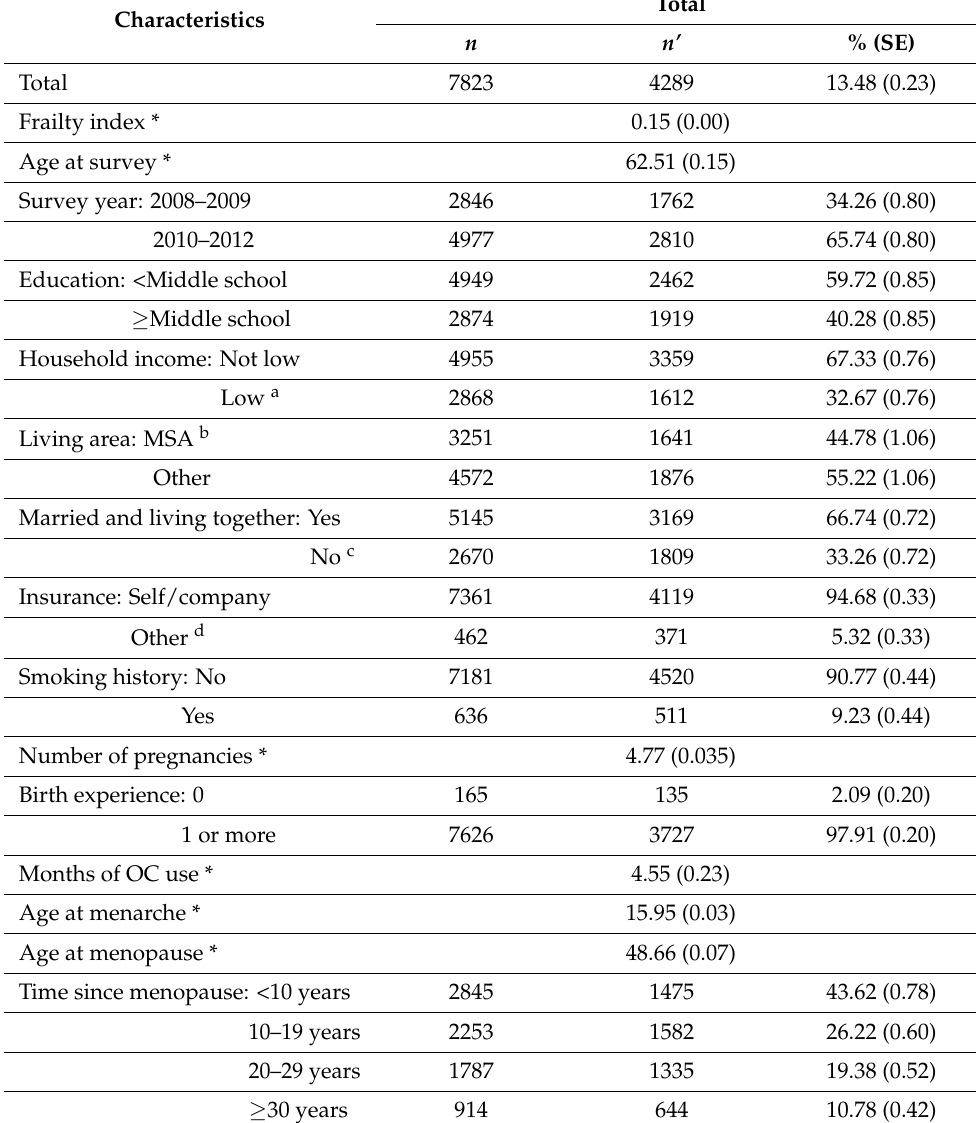
Table 1. Characteristics of study